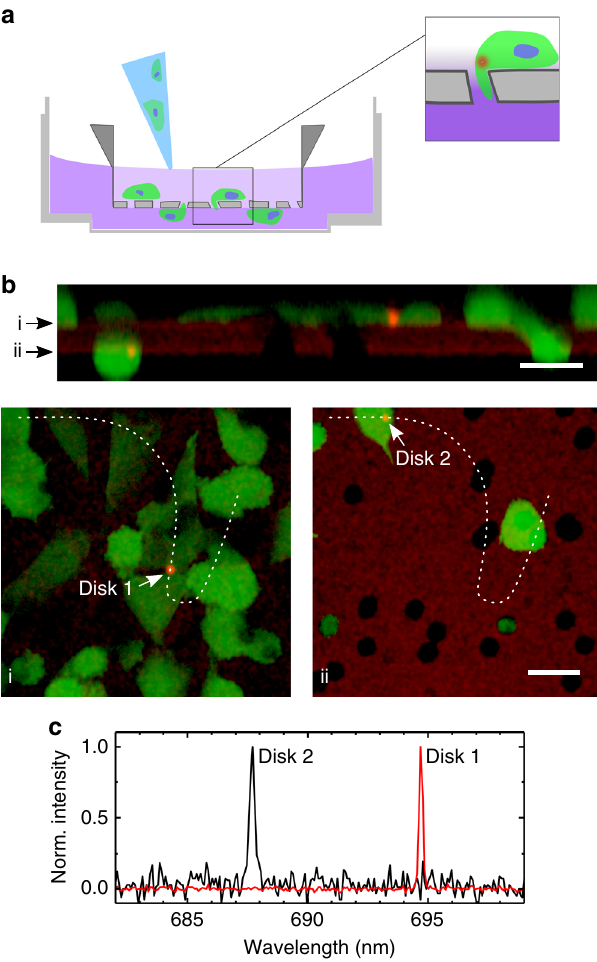
Fig. 5 Migration of cells with nanodisk lasers through a microporous membrane. a Schematic cross-section of transwell migration assay, with cell culture dish, membrane insert and disk-containing cells that are seeded into the low-nutrient medium on the top side of the membrane before migrating through pores in membrane towards nutrient-rich medium on the lower side. b Live cell laser scanning confocal microscopy of membrane insert (weak red auto- fl uorescence) with eGFP labeled NIH 3T3 cells (green) and nanodisk lasers (bright red). Arrows in top panel indicate the xy-slices shown in the bottom panels; dashed lines in bottom panels indicate the path of the cross-section in the top panel. Images use a logarithmic color scale to visualize weak membrane fl uorescence and bright disk fl uorescence simultaneously. Scale bars, 20 µ m. c Lasing spectra of Disks 1 and 2 in ( b ), recorded in parallel with confocal microscopy